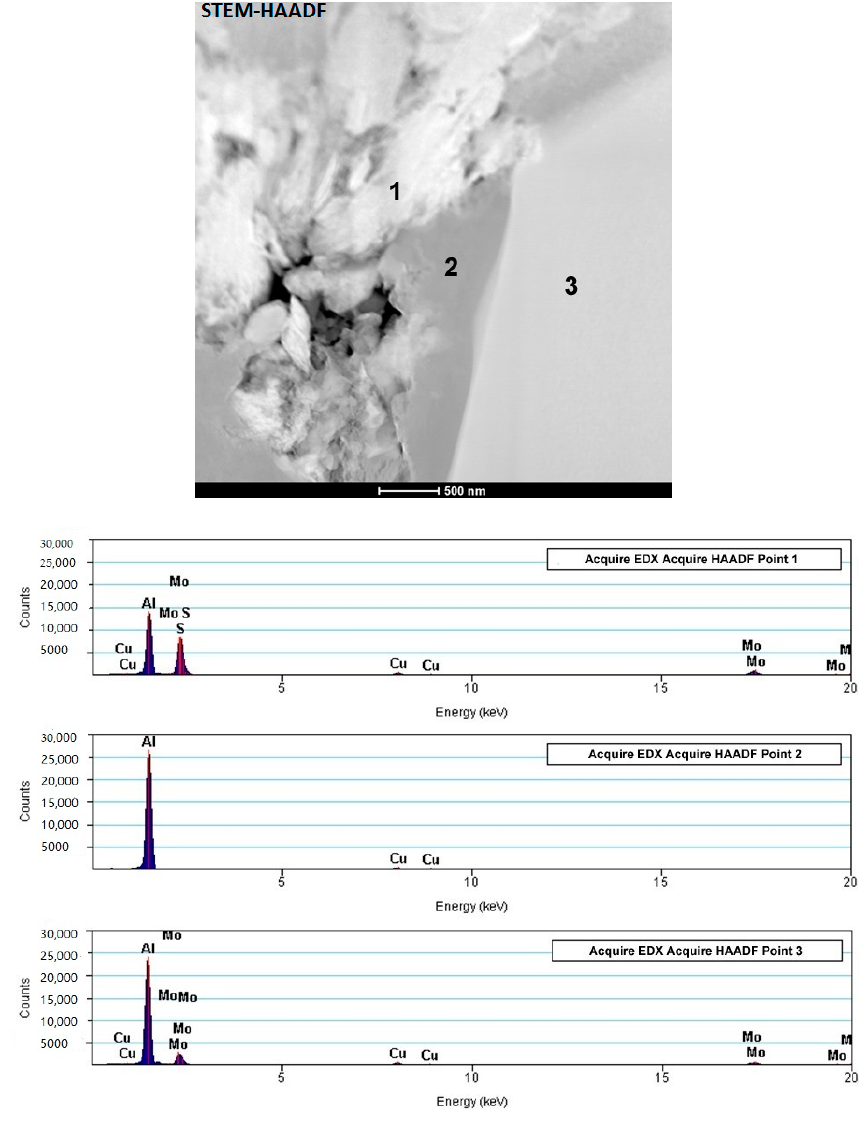
Figure 18. Microstructure and chemical analysis of selected points from AA6061/MoS 2 10 vol % SPT samples (center area λ = 1.5).